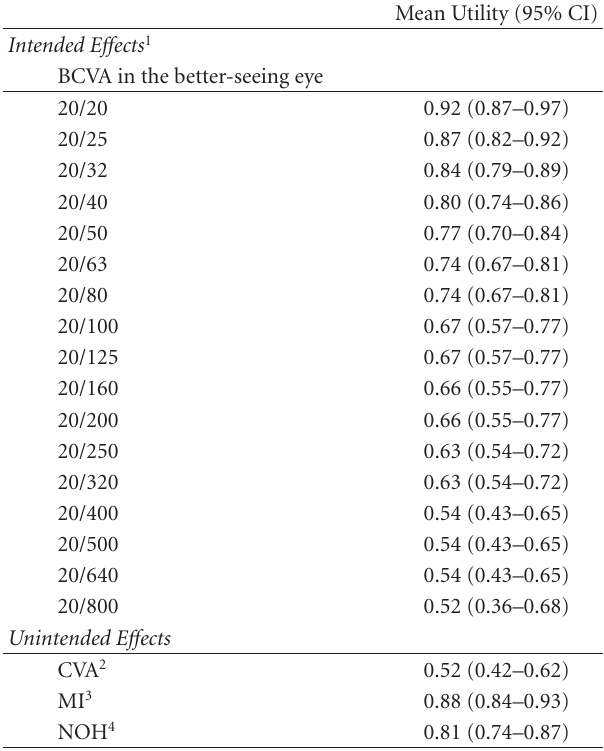
Table 2: Utilities, intended and unintended e ff